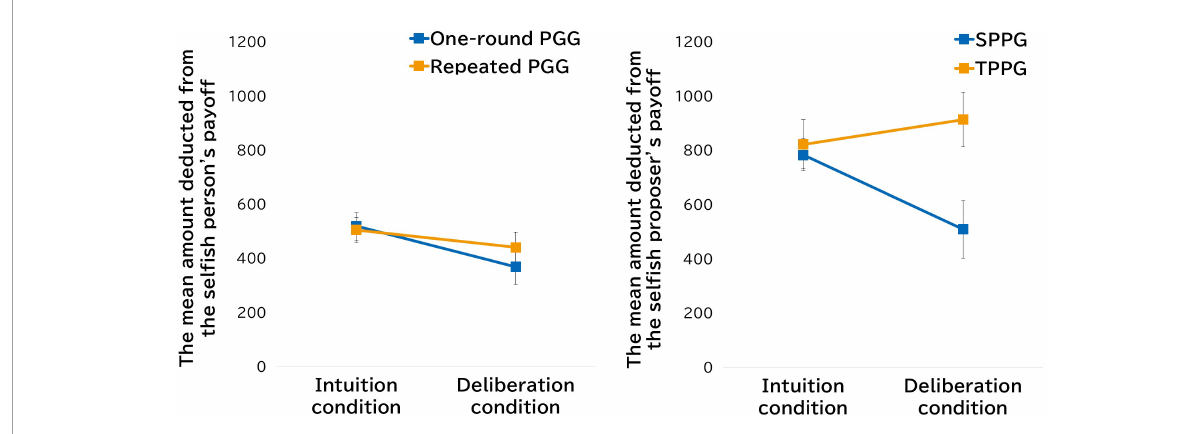
FIGURE1 Conditional differences in mean amount spent for punishment in Study 1 and Study 2.